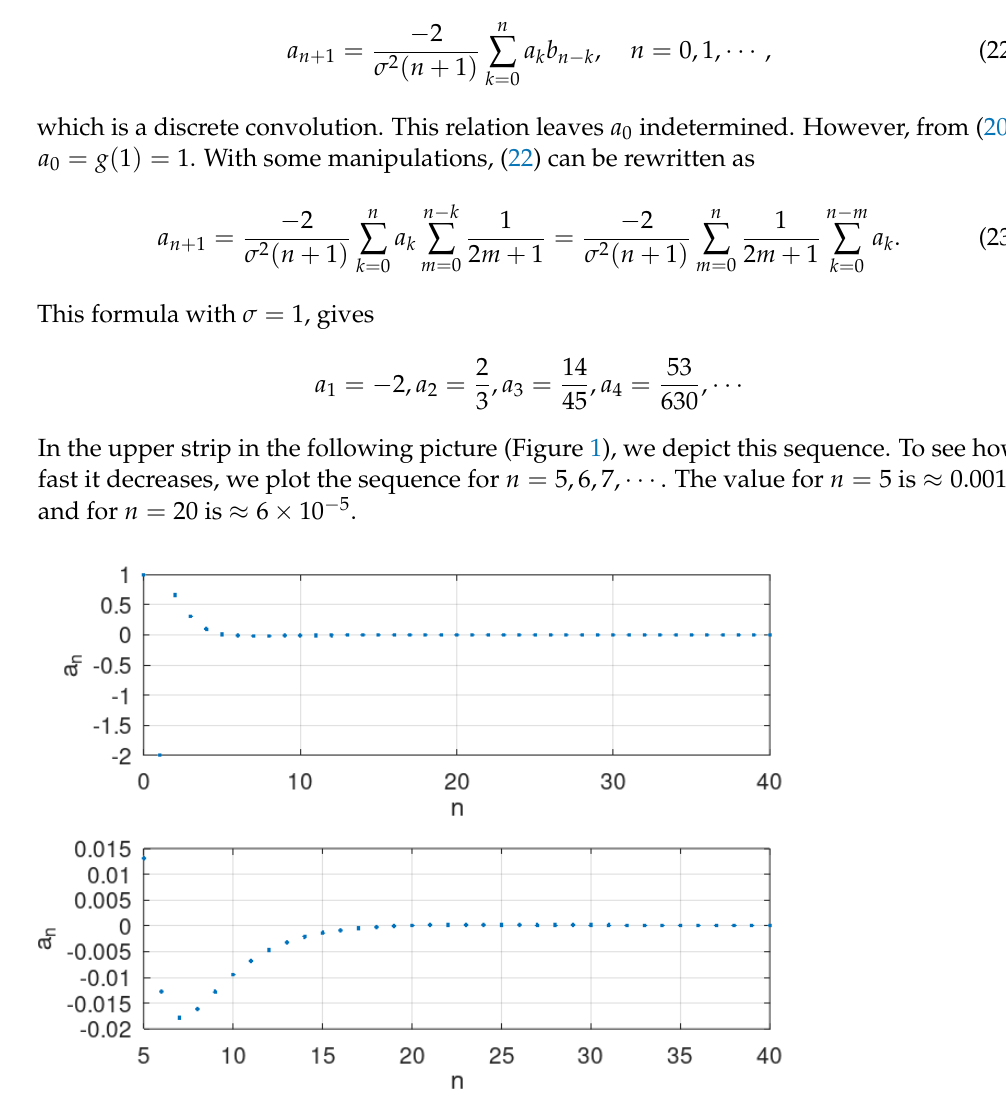
Figure 1. Numerical computation of a n , n = 0,1,2, · · · ( upper strip ); in the ( lower strip ) a zoom of the sequence, a n , n = 5,6,7, · · · , is